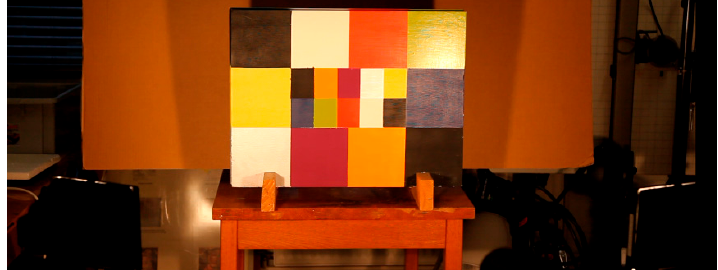
Figure 12. The sample under analysis.